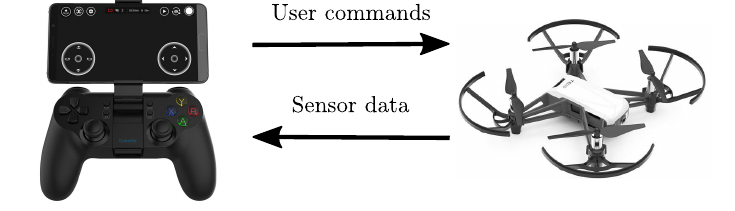
Figure 8. Experimental platform based on the DJI Ryze Tello quadrotor and the GameSir T1d bluetooth